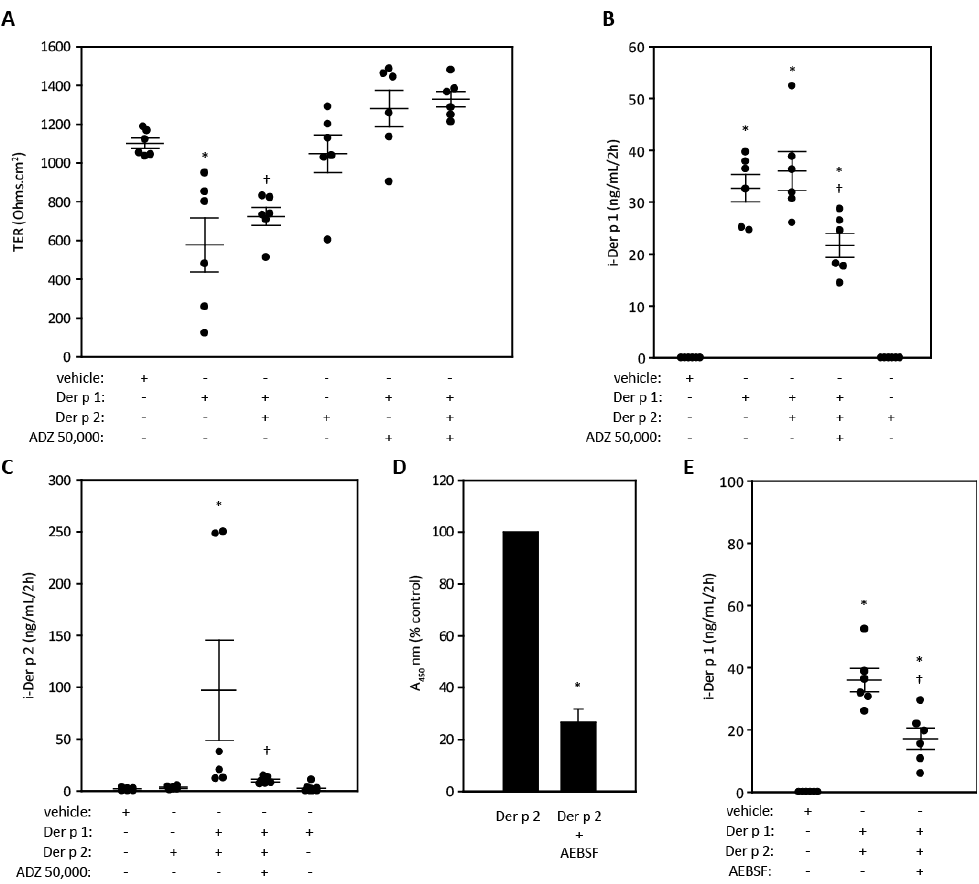
Figure 2. Effect of ADZ 50,000 on TER and the transepithelial disposition of Der p 1 and Der p 2 in the Calu-3 human airway epithelial cell line. ( A ) Contrasting actions of Der p 1 (2 µM) and Der p 2 (2.8 µM) on TER and the inhibition of Der p 1-mediated effects by ADZ 50,000 (1 µM). * p < 0.001, † p < 0.01 vs. vehicle control. Vehicle comprised serum-free EMEM containing 5 mM cysteine. ( B ) Immunoreactive Der p 1 (i-Der p 1) detected in the basolateral chamber of Transwells after 2 h incubation with apically-applied Der p 1, Der p 2 or Der p 1 with Der p 2 and the effect of ADZ 50,000. * p < 0.001 vs. vehicle control; † p < 0.01 vs. Der p 1 and Der p 2 in the absence of ADZ 50,000. ( C ) as ( B ), but measuring i-Der p 2, * p < 0.01 vs. vehicle control; † p < 0.01 vs. Der p 1/Der p 2 mixture. ( D ) Detection of contaminant serine peptidase activity in a commercial preparation of native Der p 2 and its inhibition by AEBSF (100 µM). Data are mean ± s.e. mean on 4 replicate tests on a single batch of allergen using N- Bz-Phe-Val-Arg- p -nitroanilide as substrate. * p < 0.05. ( E ) measurement of basolateral i-Der p 1 after the application of a mixture of Der p 1 and Der p 2 to the apical surface of calu-3 cells showing that AEBSF has an inhibitory effect on the serine peptidase contaminant associated with Der p 2. * p < 0.001 vs. vehicle control; † p < 0.001 vs. Der p 1 and Der p 2 in the absence of AEBSF. In ( A – C ) and in ( E ), data are shown as values from individual experiments with the mean ± s.e. indicated by the cross-hair and whiskers.